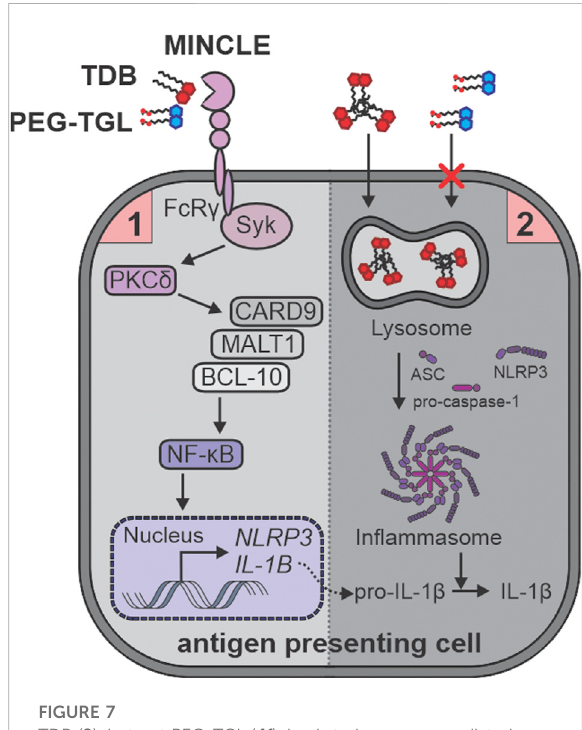
FIGURE 7 TDB ( 2 ), but not PEG-TGL ( 4f ), leads to lysosome-mediated activation of the in fl ammasome and IL-1b production. TDB ( 2 )and PEG-TGL ( 4f )are both bind to and signal via Mincle, thus providing the priming signal-1 for in fl ammasome activation. Only TDB ( 2 ) can suf fi ciently induce phagocytosis, and thus, signal-2 for in fl ammasome activation. This leads to TDB ( 2 ), but not PEG-TGL ( 4f ), mediated IL-1b